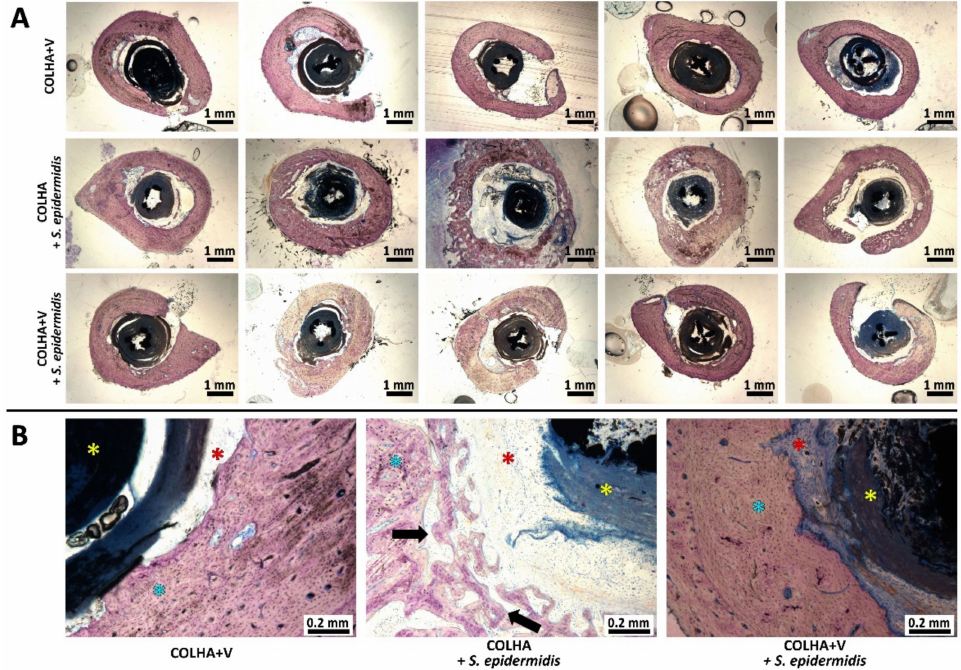
Figure 3. Representative histological images of perpendicular sections of the femurs with Giemsa’s azur eosin methylene blue staining ( A ) and details of the bone morphology ( B ) showing the bone tissue (blue stars), fibrous tissue (red stars), implants (yellow stars), and porous areas (black